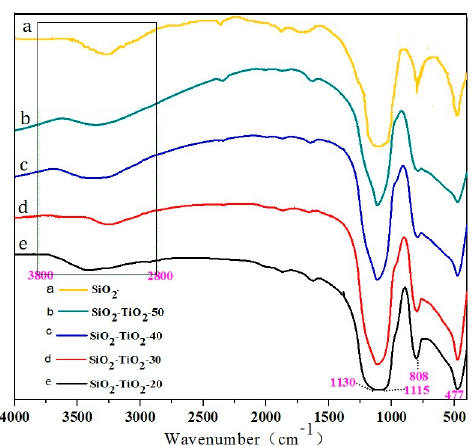
Figure 9. FT-IR of SiO 2 –TiO 2 with different TiO 2 ratios. SiO 2 –TiO 2 -20, 30, 40, 50 represent the mass ratio of TiO 2 to SiO 2 –TiO 2 is 20%, 30%, 40% and 50%; The black rectangle region represents the absorption peak caused by the vibration of the hydroxyl radical.